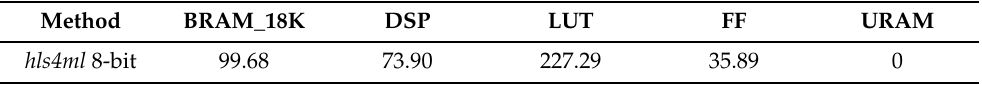
Table 13. Resource consumption (% of available resources) of CNN2D on the ZCU104 with hls4ml